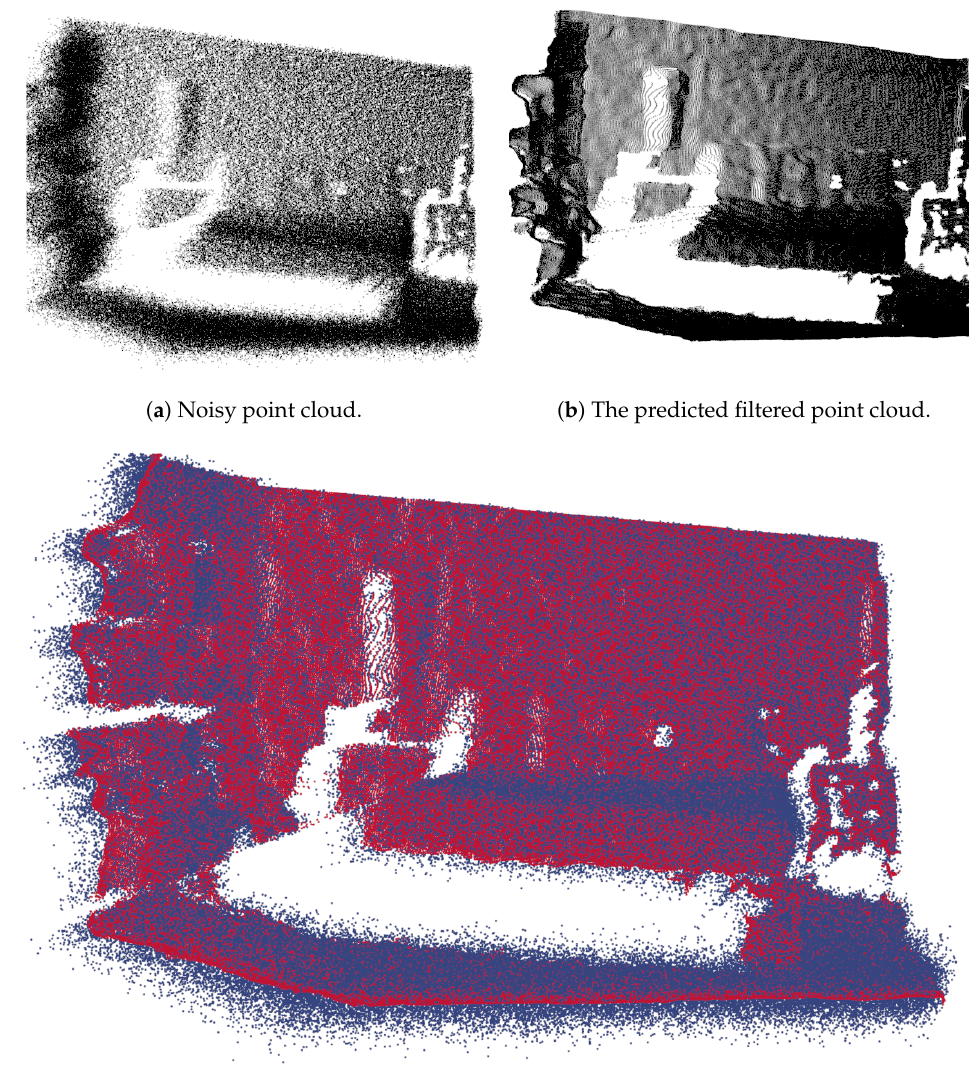
Figure 3. Comparison of noisy point clouds with the smoothed